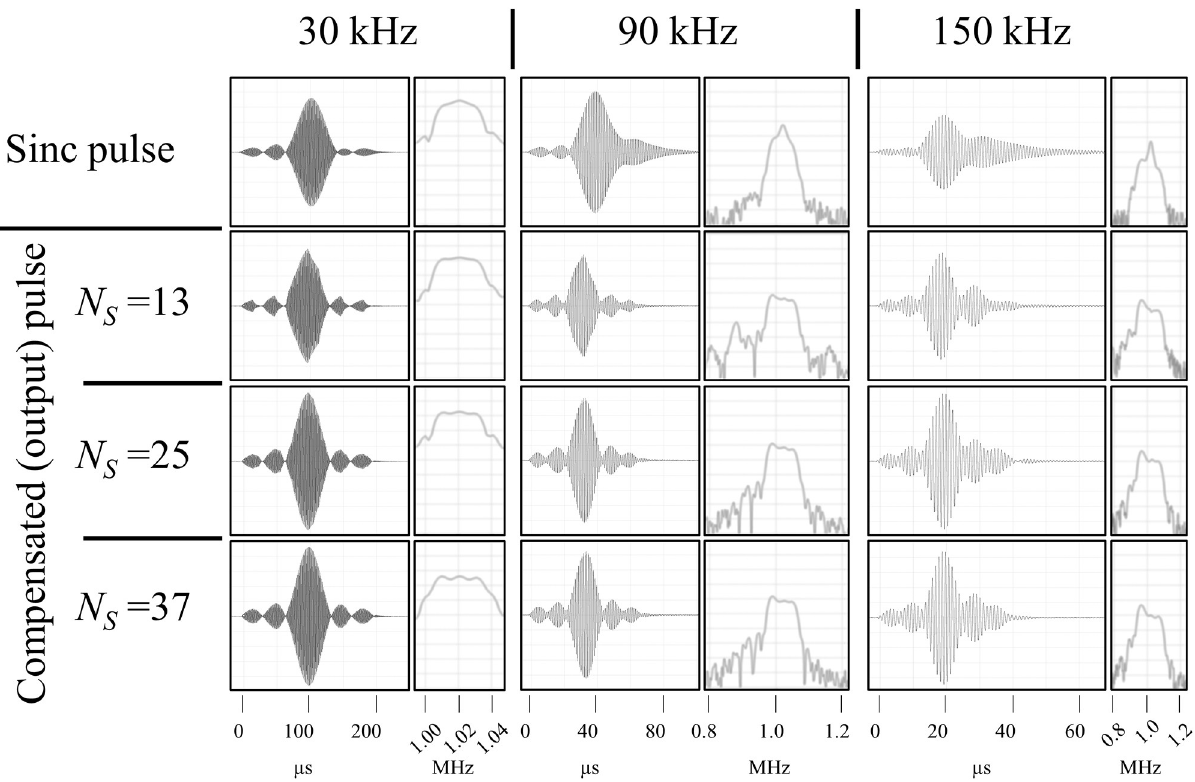
Fig 9. Measured actual pulses (output pulses, vertical dashed lines indicate the input pulse ends). And frequency spectrums of the sinc pulses (top row) and compensated sinc pulses calculated with N values of 13 (second row), 25 (third row), and 37 (bottom row) and bandwidths of 30 kHz (left S column), 90 kHz (middle column), and 150 kHz (right column). The y-axis shows normalized values (from -1 to 1 for waveforms, from 0 to 1 for frequency spectrums).